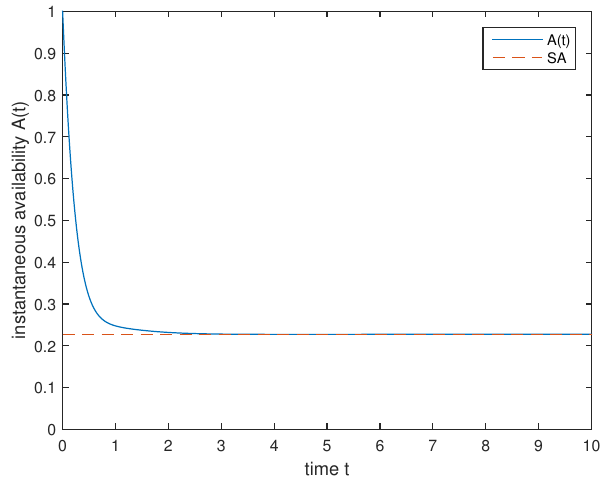
Figure 3. The curve of IA for case